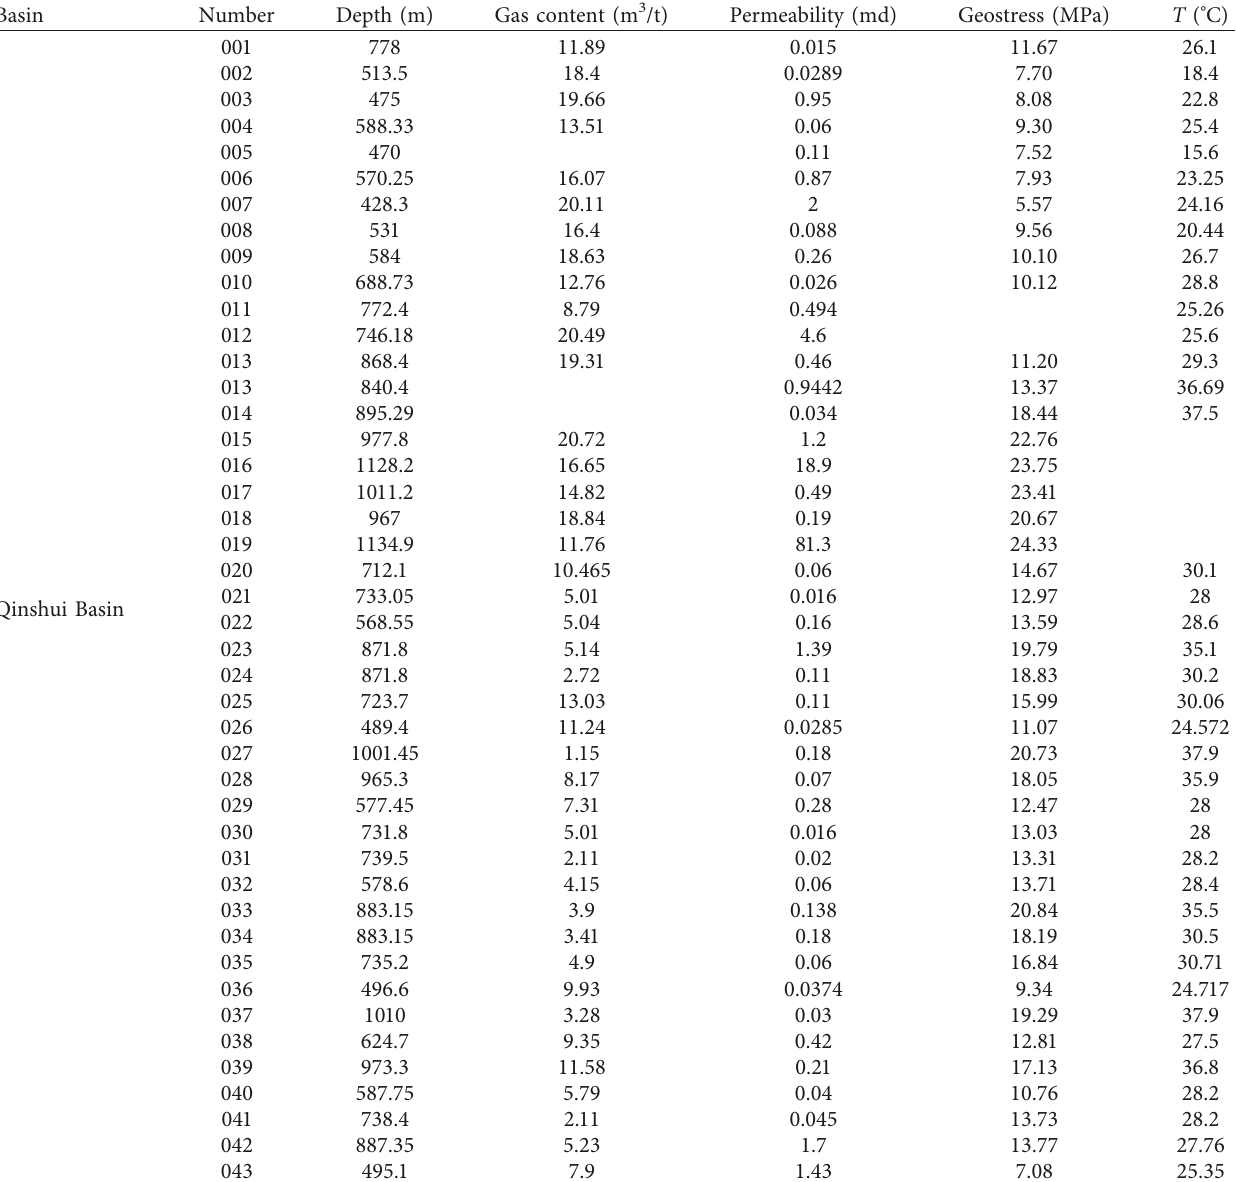
Table 1: Statistics table of depth and productivity in main CBM producing wells.